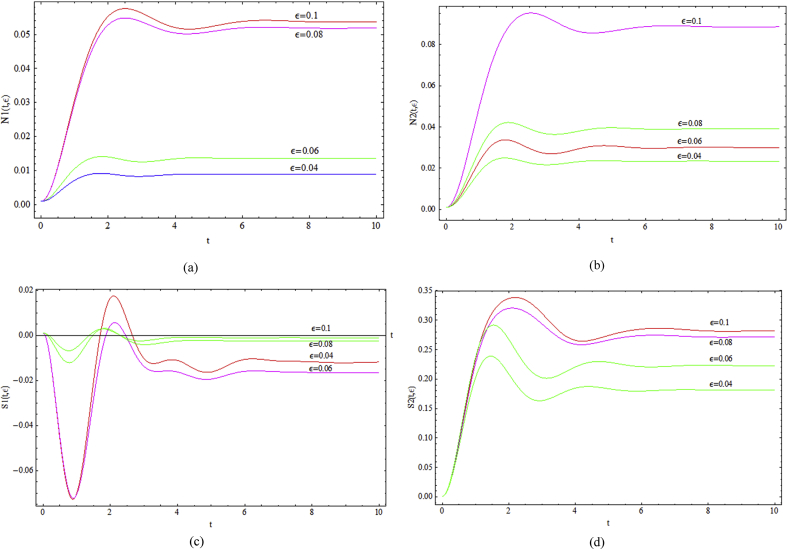
Transient behavior of a) N1, b) N2, c) S1 and d) S2, for various ε with We = 0.15, Δp = -1, ζ = 0.2 and Re = 0.2.